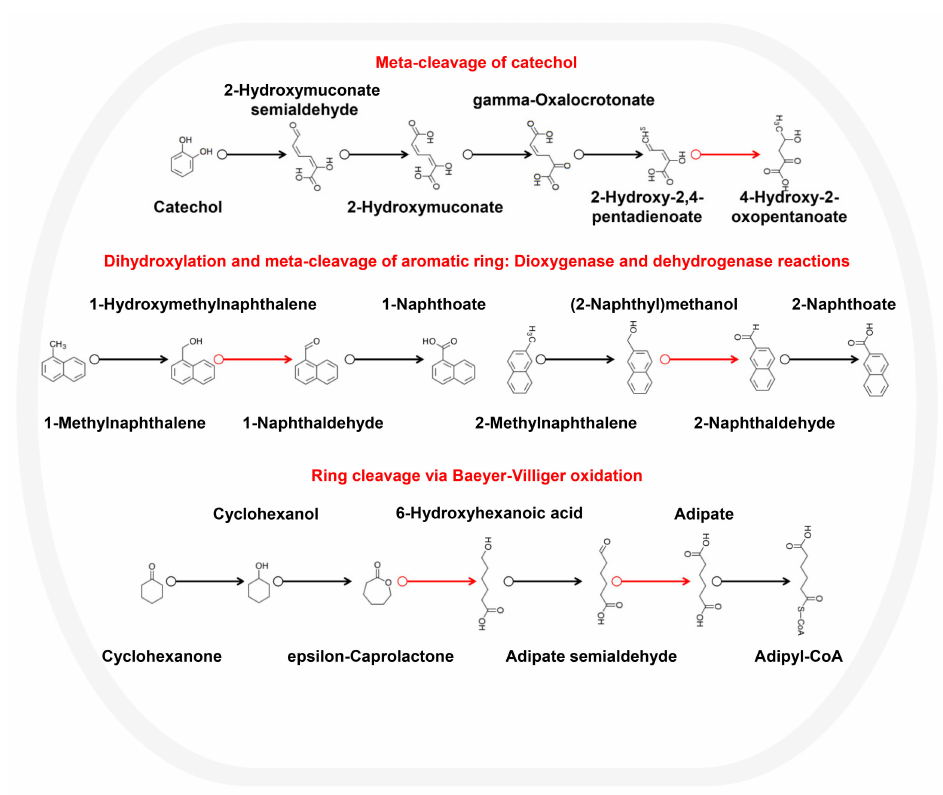
Figure 4. Sphingomonas sp. metabolic pathways for the degradation of aromatic compounds.